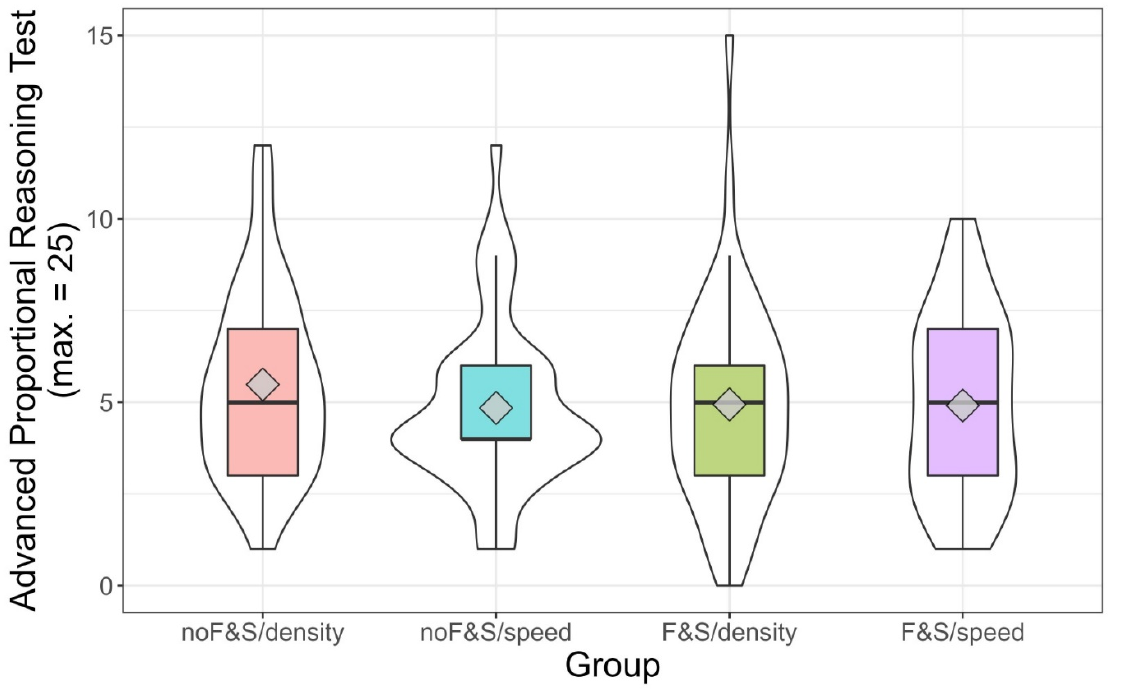
Figure 2. Score on the advanced proportional reasoning test by group in Study 1. Violin plots (white) and boxplots (colored). The diamond depicts the mean value per group.